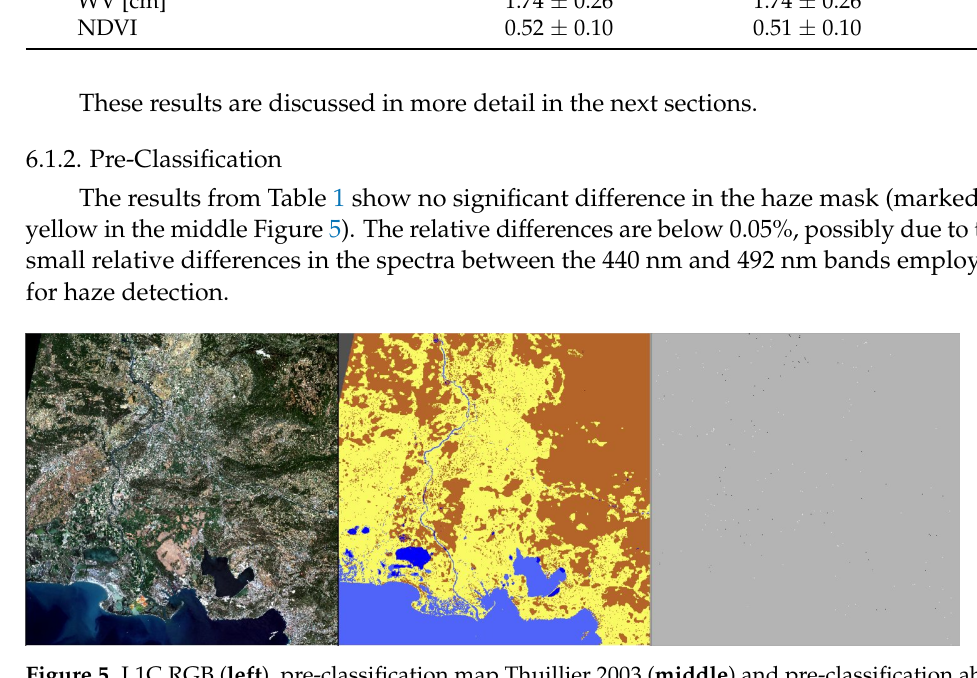
Figure 5. L1C RGB ( left ), pre-classification map Thuillier 2003 ( middle ) and pre-classification abso- lute difference map between TSIS and Thuillier masks product ( right ), where the grey color represents a zero difference. The pre-classification mask tags present in the middle plot are: clear land (brown), clear water (dark blue) and haze over land (yellow) and over water (light